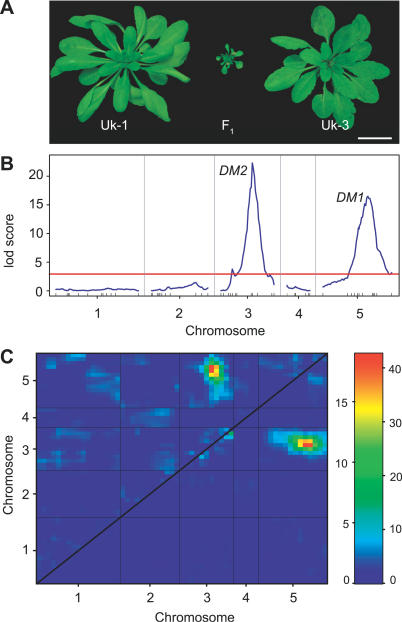
Uk-1 × Uk-3 Hybrid Phenotype and QTL Mapping(A) Uk-1 (left), Uk-1/Uk-3 F1 hybrid (middle), and Uk-3 (right) plants grown at 16 °C. Scale bar represents 2 cm.(B) QTL mapping using 181 individuals identifies two regions associated with the F1-like phenotype in F2 populations. Red line delineates significance threshold (p = 0.05, established by 1,000 permutations); tick marks indicate marker positions.(C) Heat map for two-dimensional genome scan with a two-QTL model for maximum joint lod (upper triangle) and interaction lod (lower triangle) scores. Color-coded scale indicates values for epistatic interaction on the left, and joint lod score on the right.